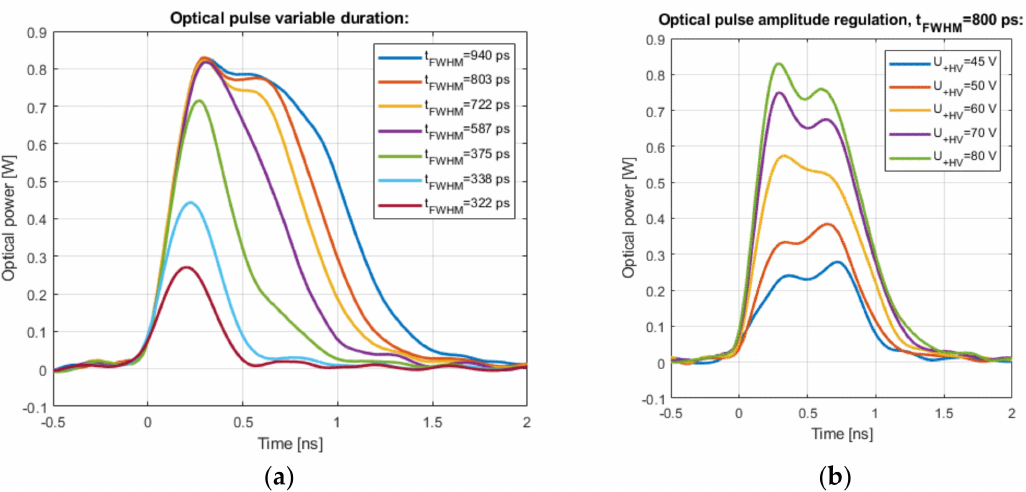
Figure 9. Tests of the developed pulsed driver coupled with the NIR laser diode: ( a ) Pulse width regulation; ( b ) pulse peak current regulation.